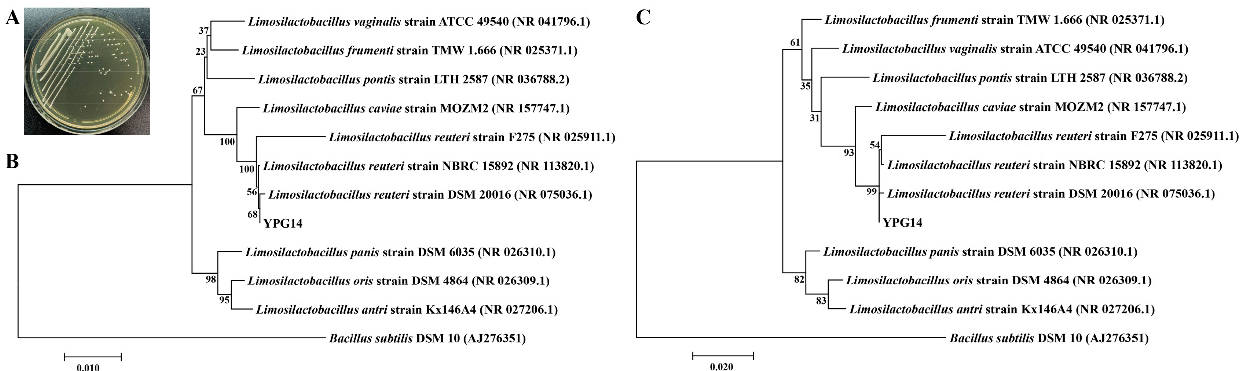
Figure 4. Phylogenetic analysis of the strain YPG14. ( A ) Colony morphology of the strain YPG14; ( B ) Neighbor-joining and ( C ) maximum likelihood phylogenetic tree based on the 16S rRNA gene sequence of the strain YPG14 (1445 bp) showed the taxonomic position of the strain YPG14 and closely related taxa. Bootstrap values (percentages of 1000 replications) are shown at branch points. Bacillus subtilis DSM 10T (GenBank accession no. AJ276351) was used as outgroup. The bar, 0.01 and 0.02 nucleotide substitutions per